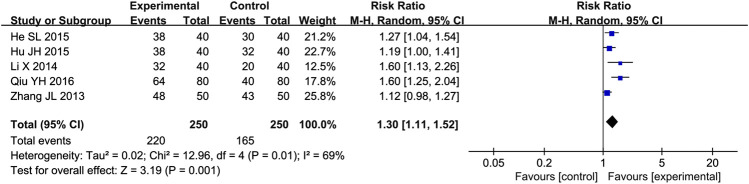
Forest plot of cardiac function improvement rate.